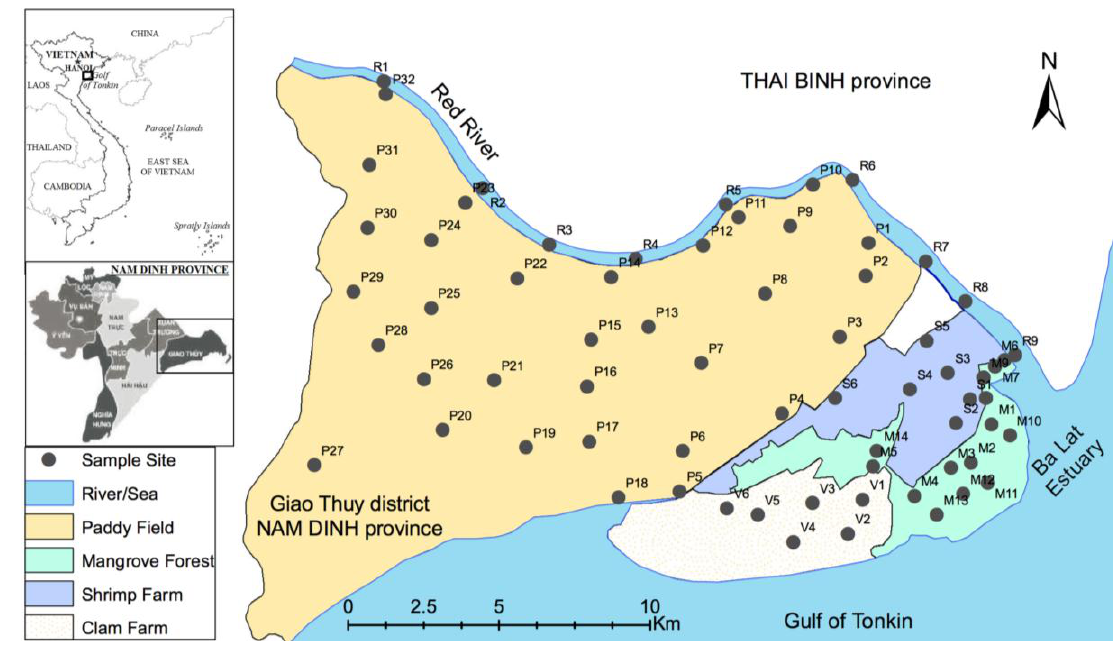
Figure 1. Study area and soil collection sites in the Ba Lat estuary.